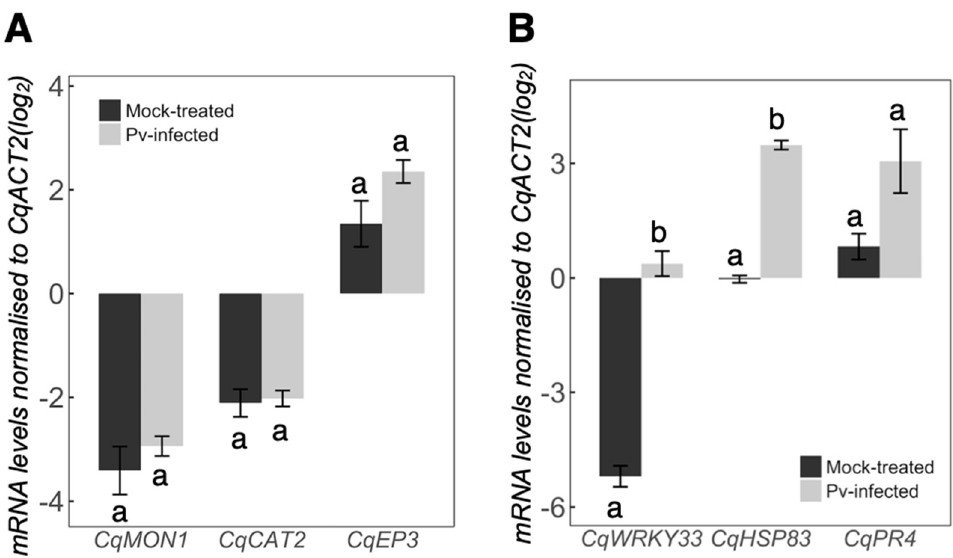
Figure 6. Gene expression in quinoa plants in response to P. variabilis . The figure shows defense response gene orthologs of quinoa cv. Kurmi at 48 h after spray-inoculation with P. variabilis or mock control. ( A ) Quinoa reference gene ( CqMON1 ) and protein-coding genes ( CqCAT2 and CqEP3 ). ( B ) Quinoa genes ( CqHSP83 , CqWRKY33 and CqPR4 ) with putative defense response functions. Data are shown as average log2 ratios of target gene to CqACT2 , and error bars denote SE. Significant differences ( p < 0.05) between infected and mock are denoted by different lowercase letters.